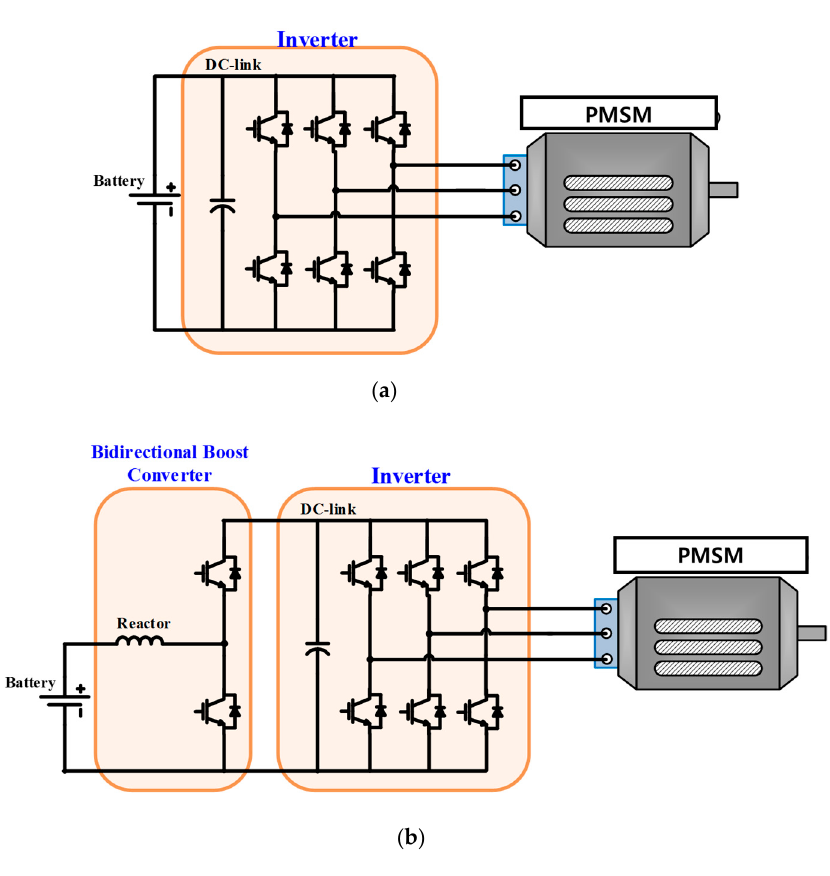
Figure 1. Power conversion unit of PMSM drive for regenerative control: ( a ) General topology of PMSM drive; ( b ) PMSM drive with DC-DC converter.